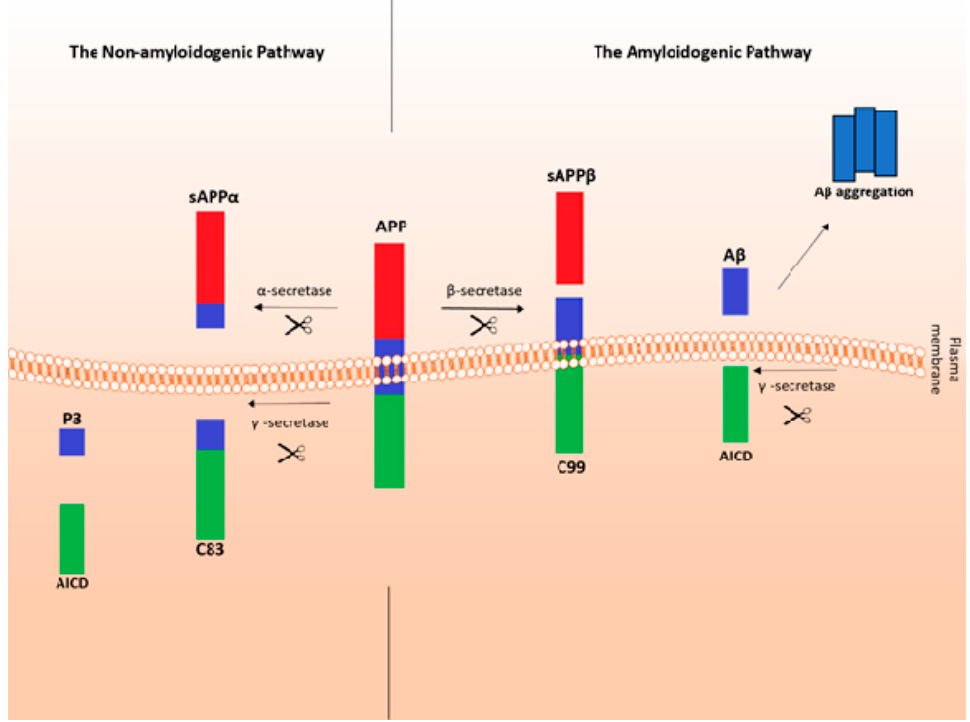
Figure 1. Amyloid precursor protein (APP) processing pathways. APP, a transmembrane protein may be processed in two pathways: the amyloidogenic pathway ( β -secretase pathway) and the non-amyloidogenic pathway ( α -secretase pathway). In the non-amyloidogenic pathway, α -secretase cleaves APP in a way that prevents the formation of amyloid- β (A β ). It releases the APP C-terminal fragment 83 (C83) and soluble amyloid precursor protein α (sAPP α ). C83 is later cleaved by γ -secretase to release the APP intracellular domain (AICD) and P3 fragment. In the amyloidogenic pathway, in turn, β -secretase cleaves APP to release sAPP β (soluble amyloid precursor protein β ), and the APP C-terminal fragment 99 (C99). C99 is later cleaved by γ -secretase, resulting in the release of A β and AICD.